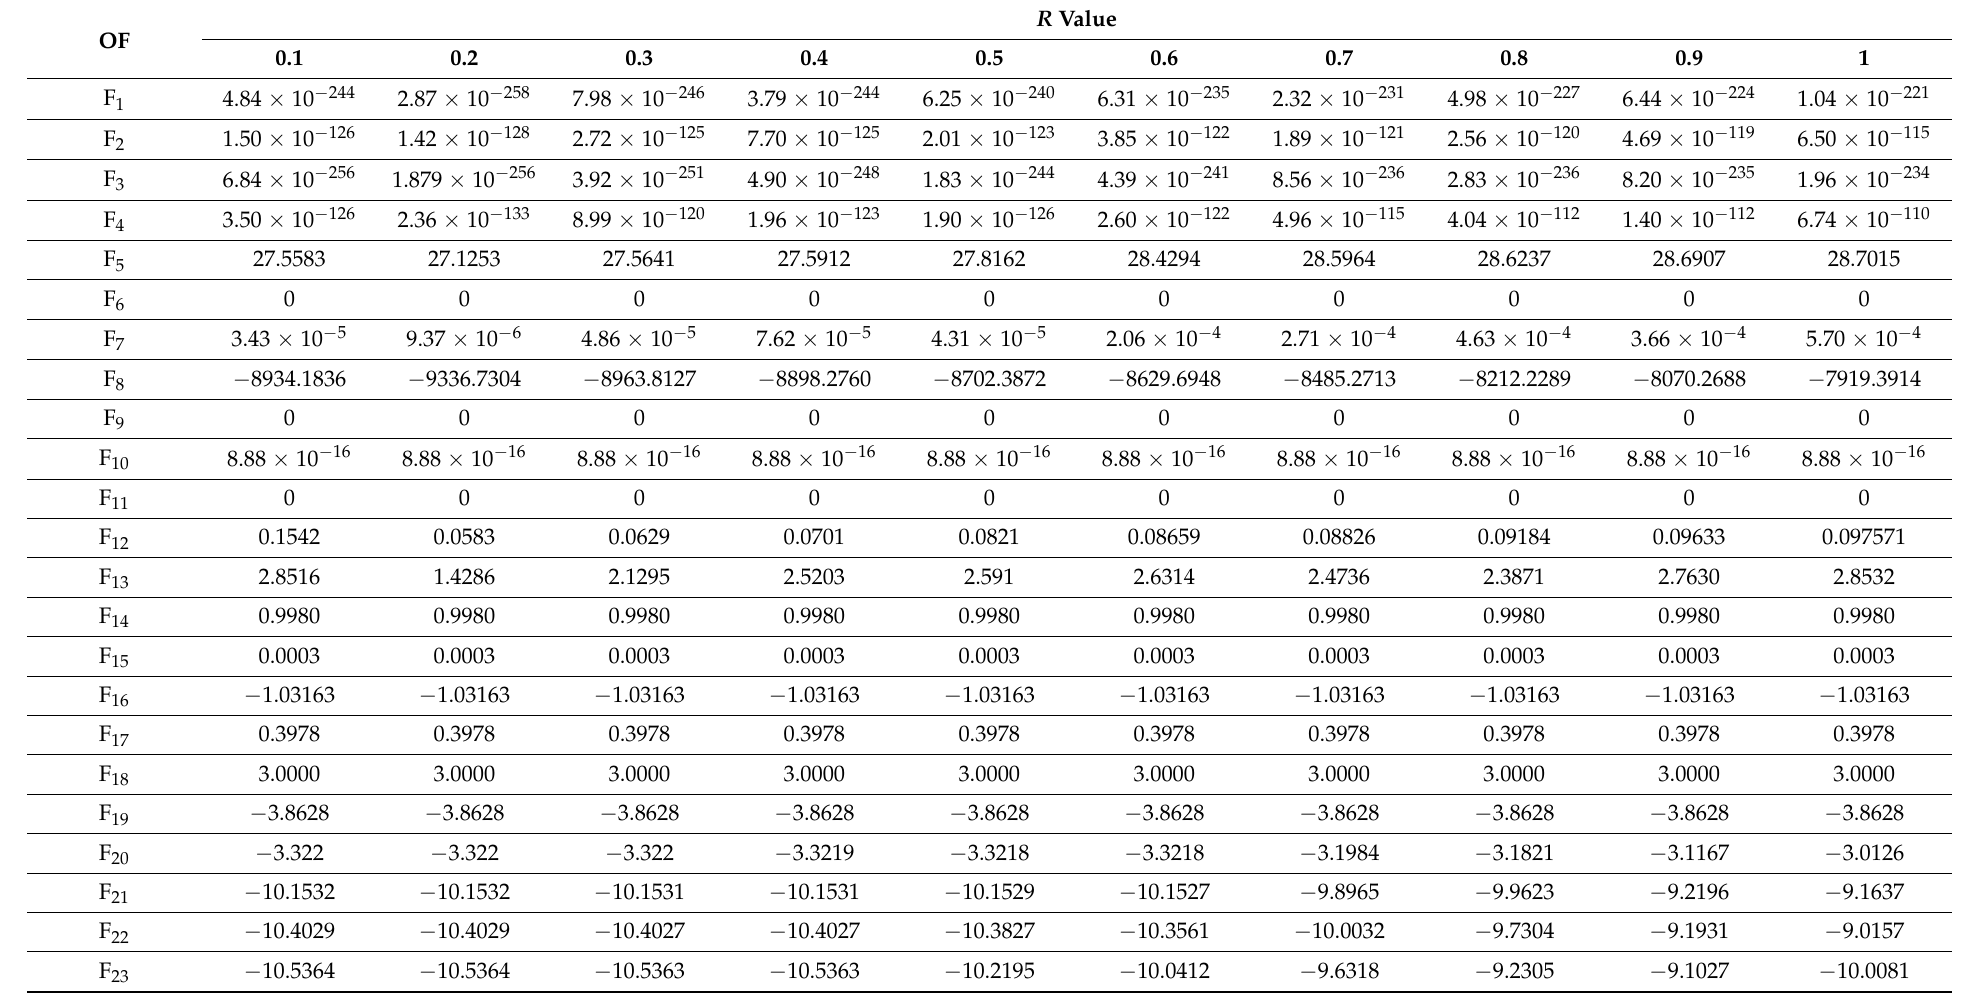
Table 8. Sensitivity analysis of the POA to R